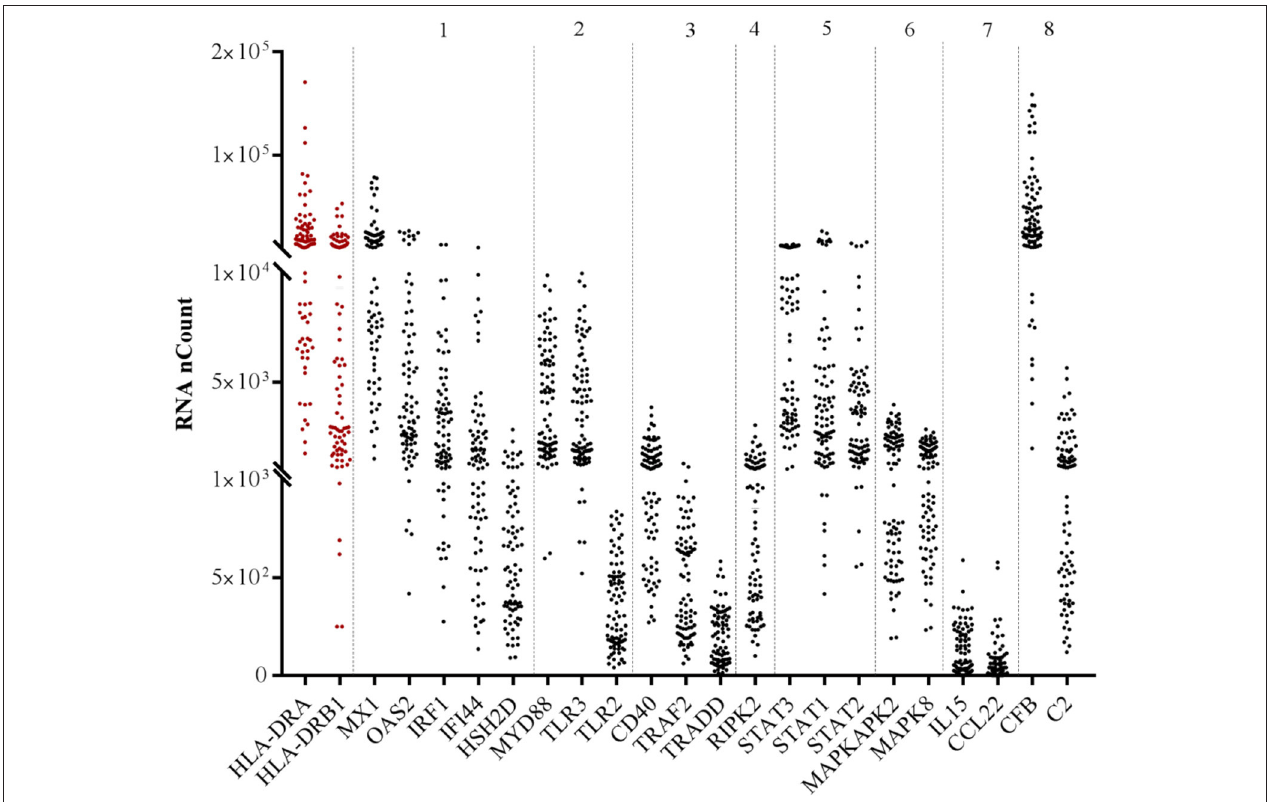
FIGURE 1 | RNA abundance of the selected highly correlated genes with both HLA-DR transcripts according to their family. RNA abundance is represented by the detected RNA copies on the y-axis. Numbers above the hatched rectangle correspond to each target family selected: (1) IFN and ISGs, (2) TNF superfamily, (3) TLR and related factors, (4) chemokines/cytokines, (5) complement and CRP (6) RIPK enzymes, (7) STAT, (8)